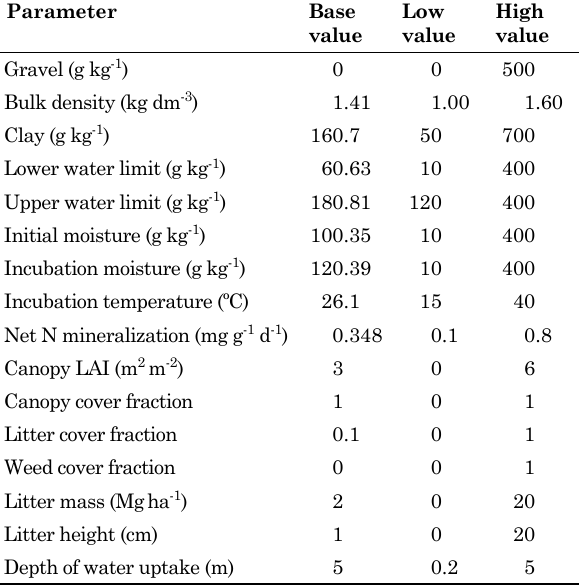
table 2. Base, low and high values of parameters used for the sensitivity